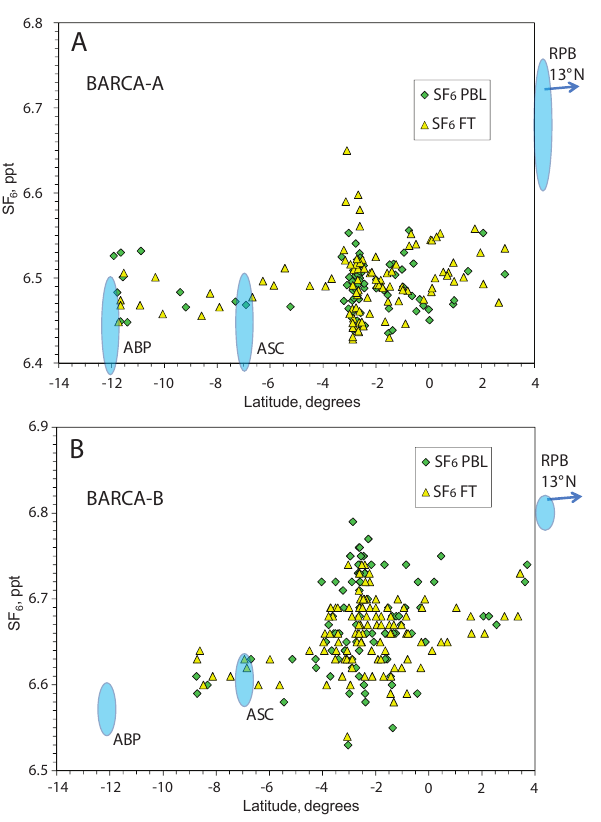
Fig. 3. Mixing ratios of sulfur hexafluoride (SF 6 ) versus lati- tude, measured in flask samples taken during BARCA-A (A) and BARCA-B (B) . The values obtained simultaneously at the NOAA monitoring sites Ragged Point, Barbados (RPB), Arembepe, Brazil (ABP), and Ascension Island (ASC) are indicated for reference.